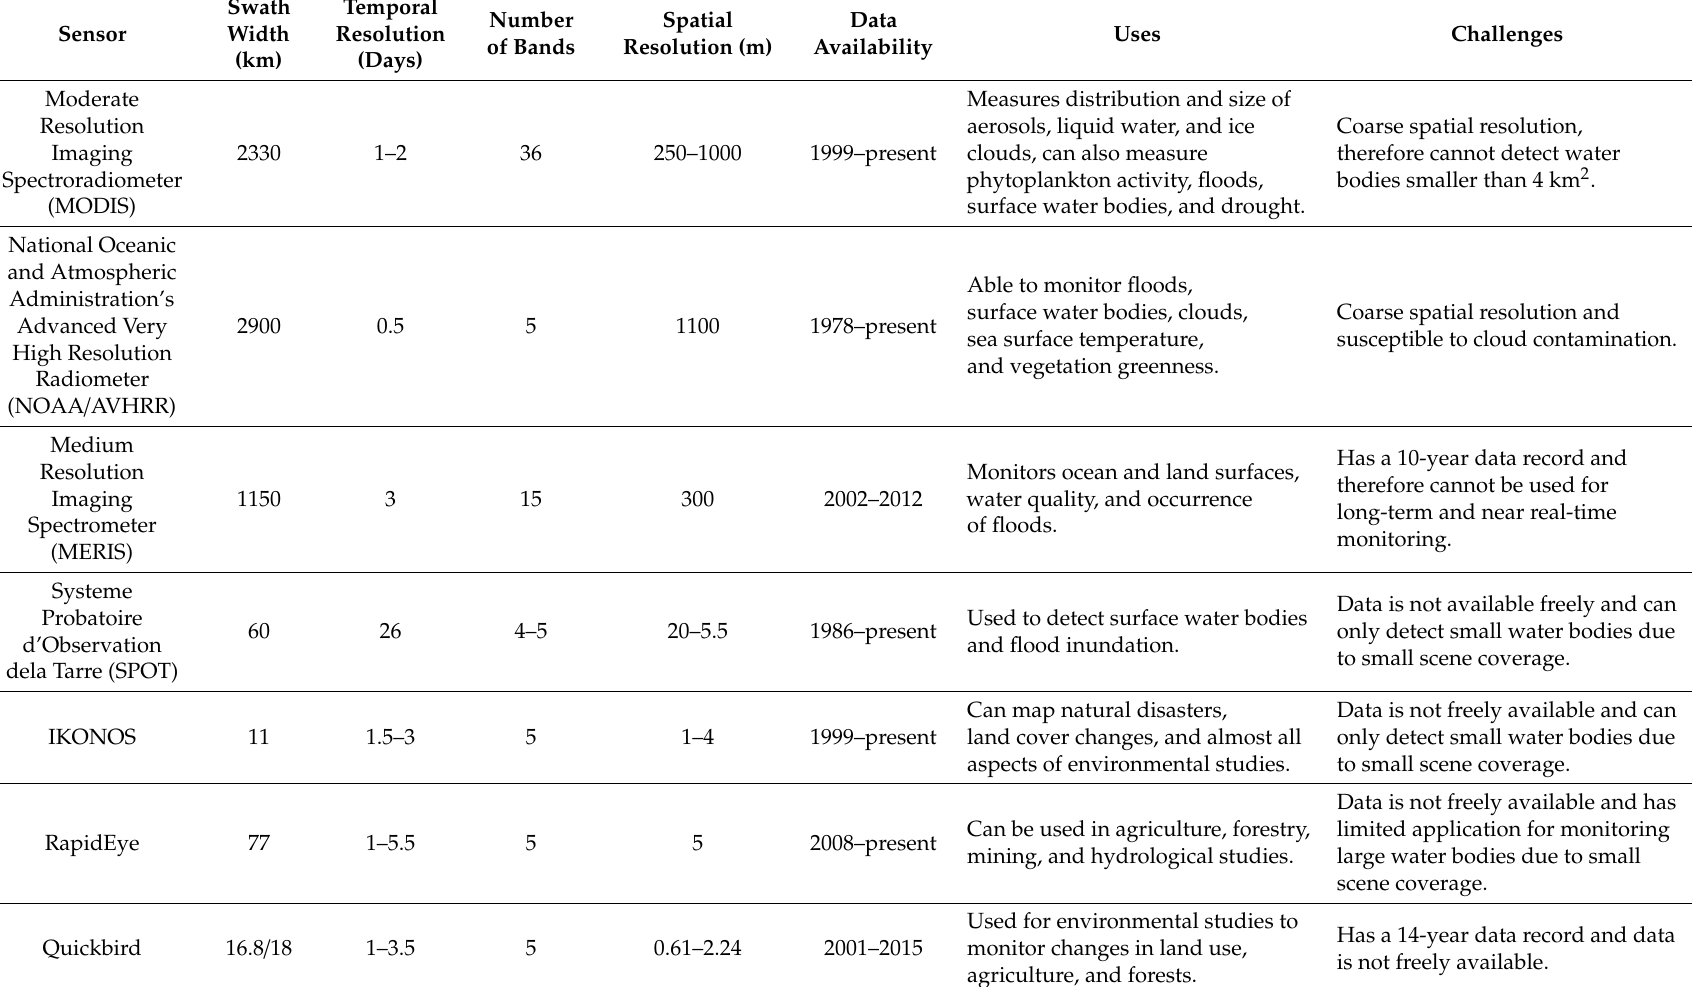
Table 2. Summary of remote sensors